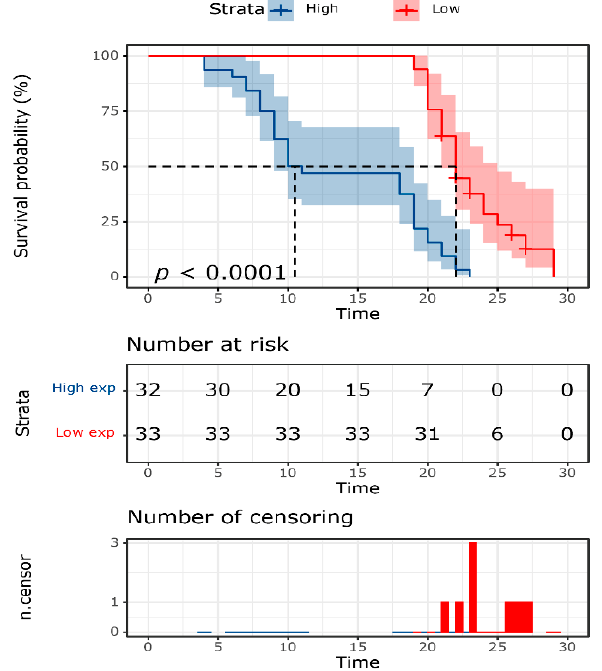
Figure 5. Kaplan–Meier curve of overall survival of patients with renal cell carcinoma stratified by the median value of HSP70 expression level ( p < 0.05).